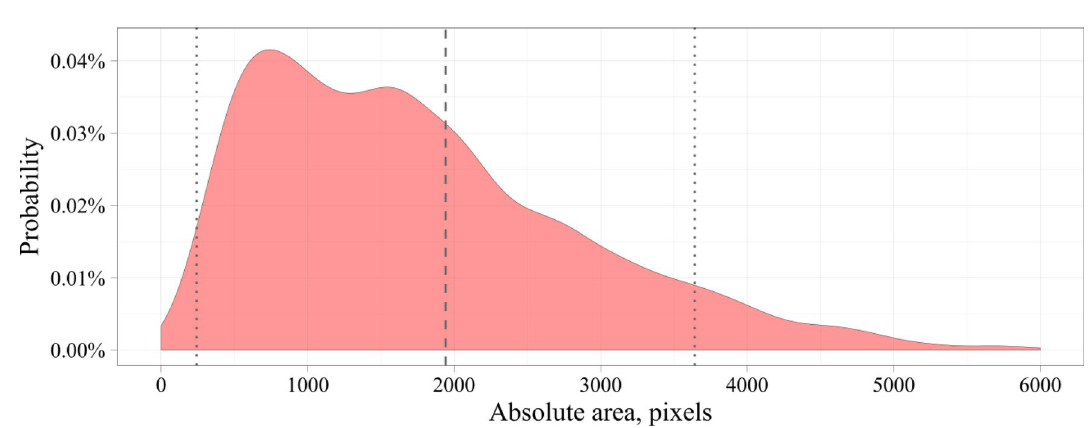
Figure 2. Distribution of the absolute stenotic area in the input